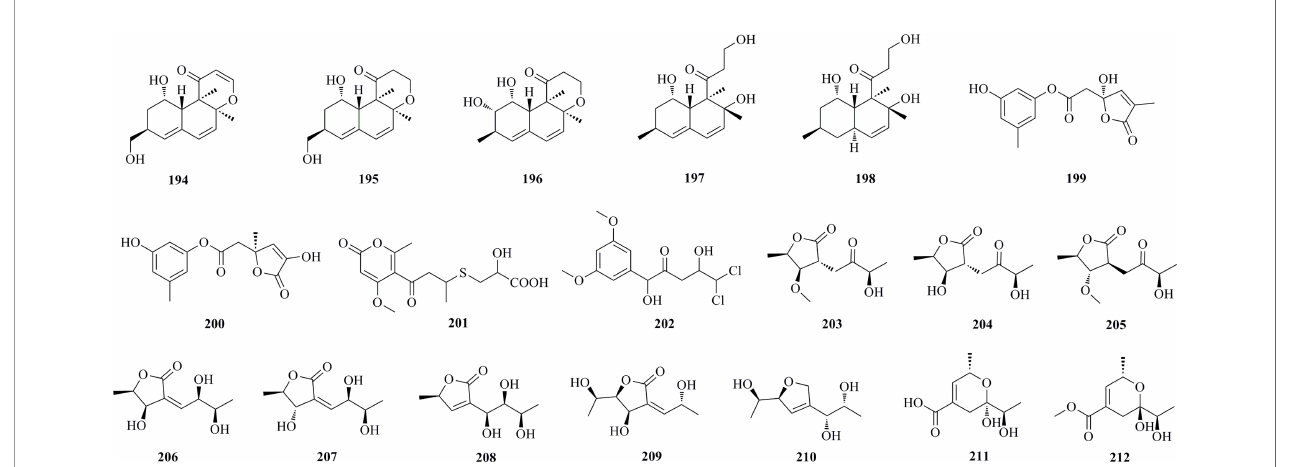
FIGURE 11 | Other polyketides isolated from deep-sea fungi (continued) ( 194 − 212